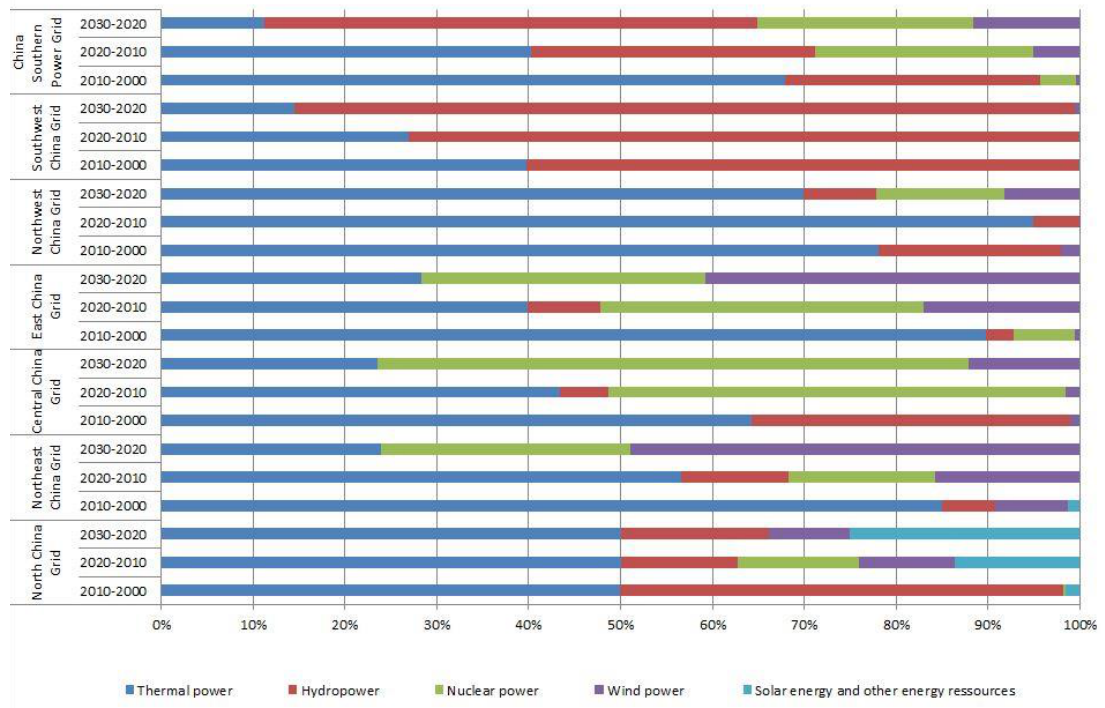
Figure 2. The share of newly installed power generation in the regional grids in China from 2000 to